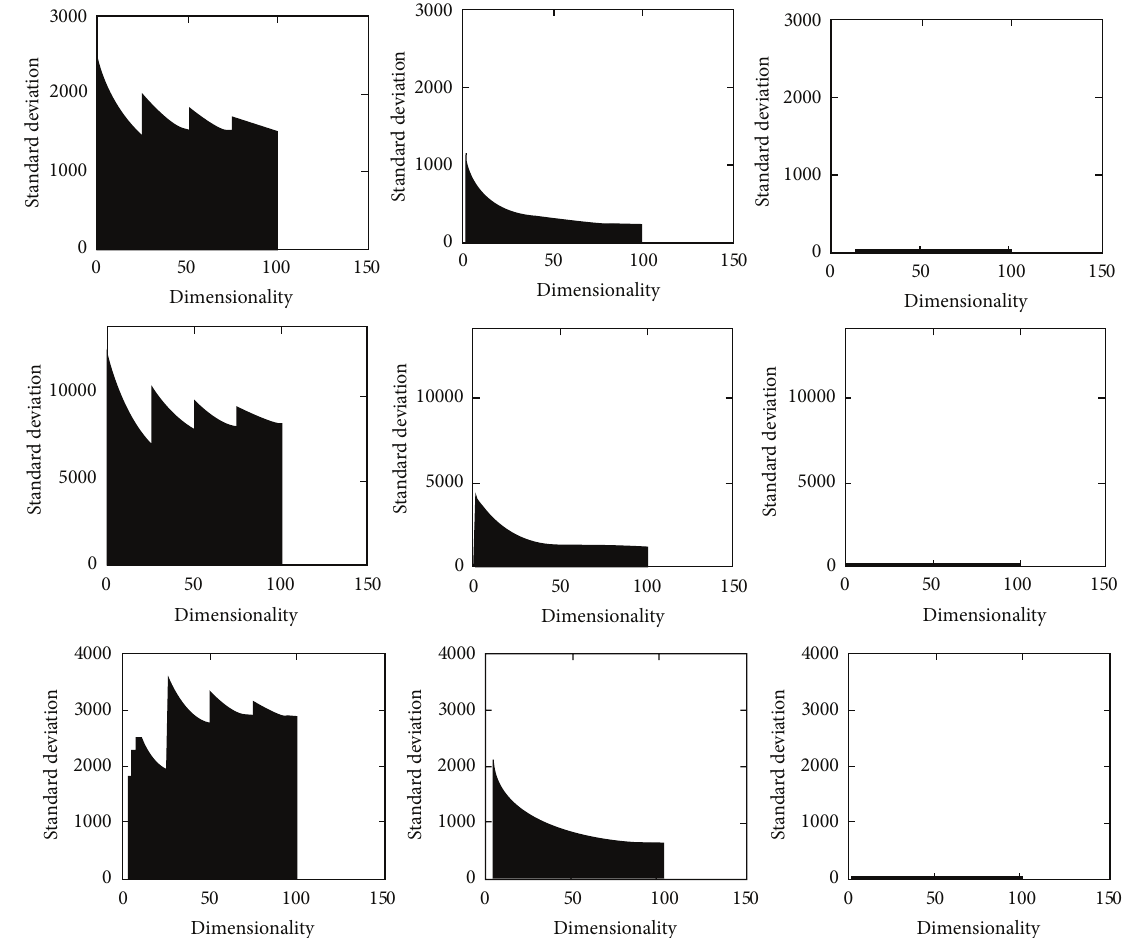
Figure 2: Standard deviation distributions of the extracted features. The rows indicate the standard deviation distributions of the features extracted from gray-scale images, red channel, and Cb channel of the colored images, respectively. The first column indicates the original features. The second column shows the features after applying PCA, while the third column shows the features after applying kernel